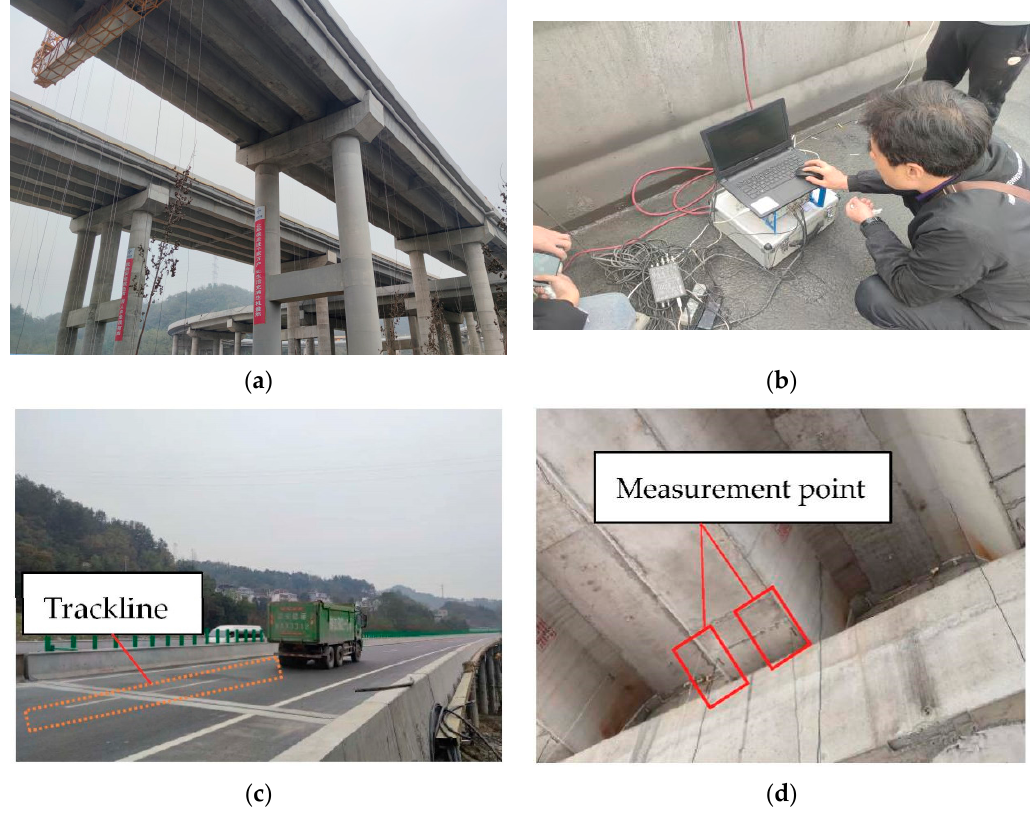
Figure 21. Representative photographs of the static and dynamic load tests. ( a ) Bridge appearance; ( b ) Data acquisition process; ( c ) Static and dynamic load tests; ( d ) Strain sensor arrangement.